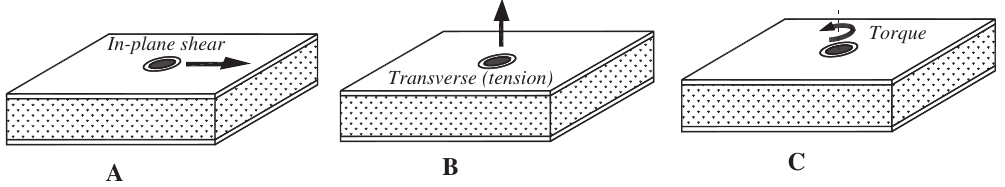
Figure 1 Three types of loads at junction points in sandwich composites: (A) shear, (B) transverse (tension), and (C)